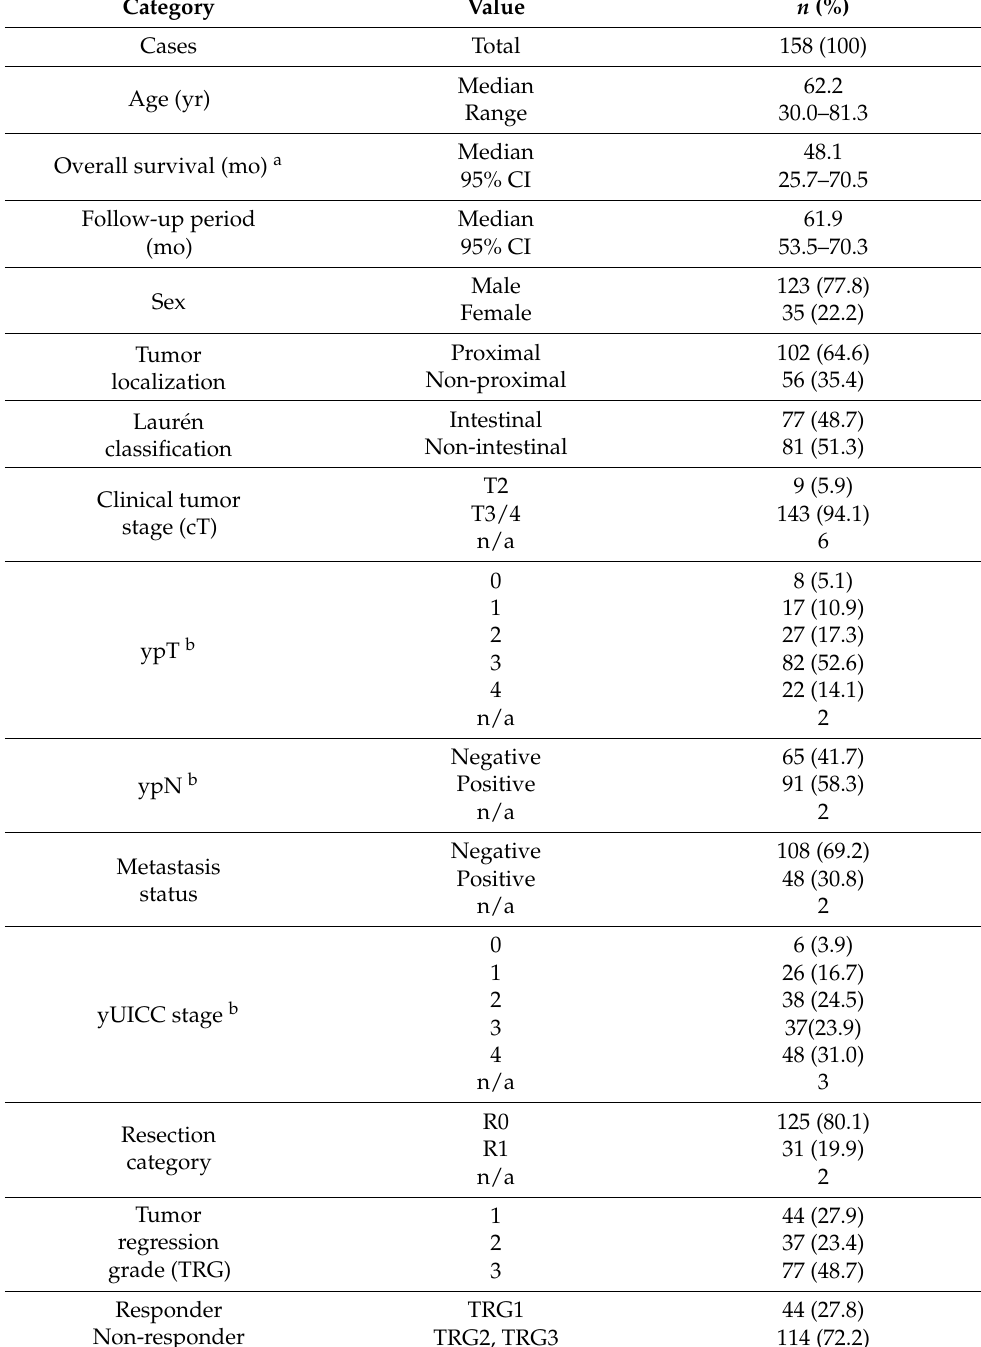
Table 1. Patient